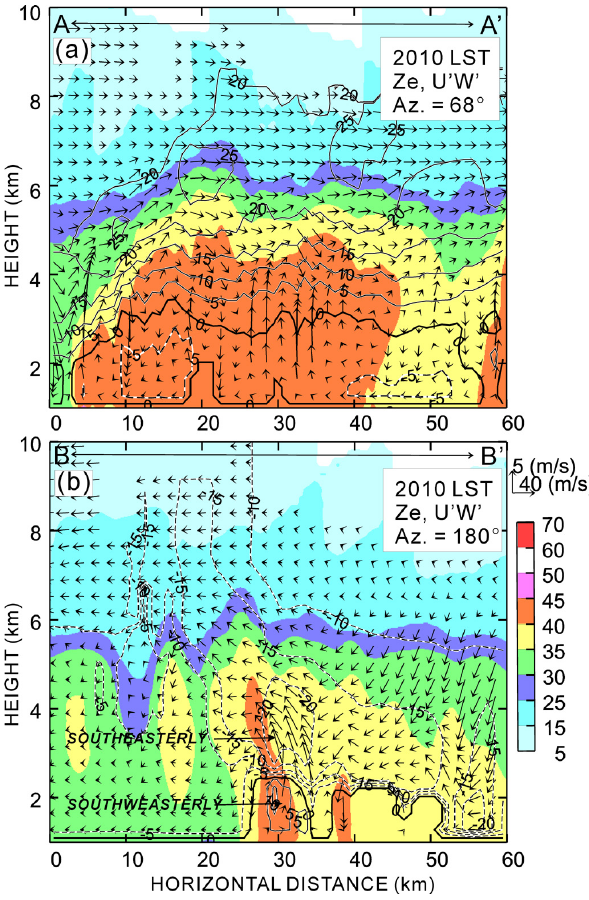
Fig. 13. Reflectivity and wind pattern in the vertical cross sections (A–A 0 and B–B 0 ) at 20:10LST, 9 July 2007. The bold lines indicate the interfaces with no horizontal wind through the section plane. The solid (dashed) contours indicate the positive (negative) veloci- ties of horizontal winds into (out of) the section